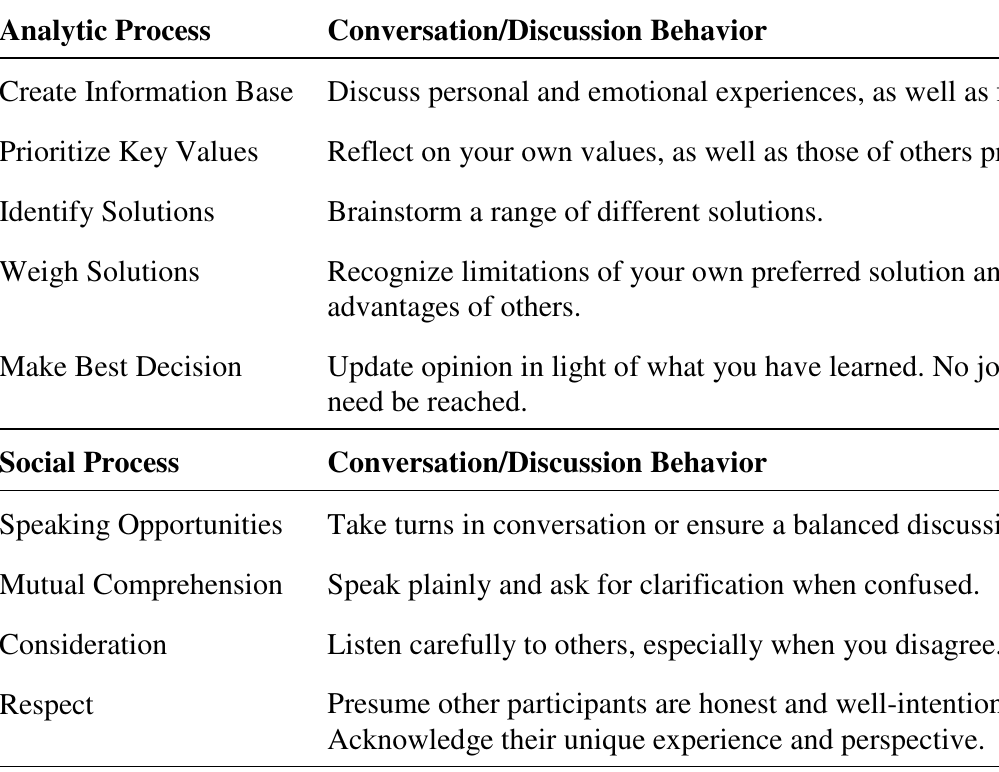
Key Features of Deliberative Conversation and Discussion